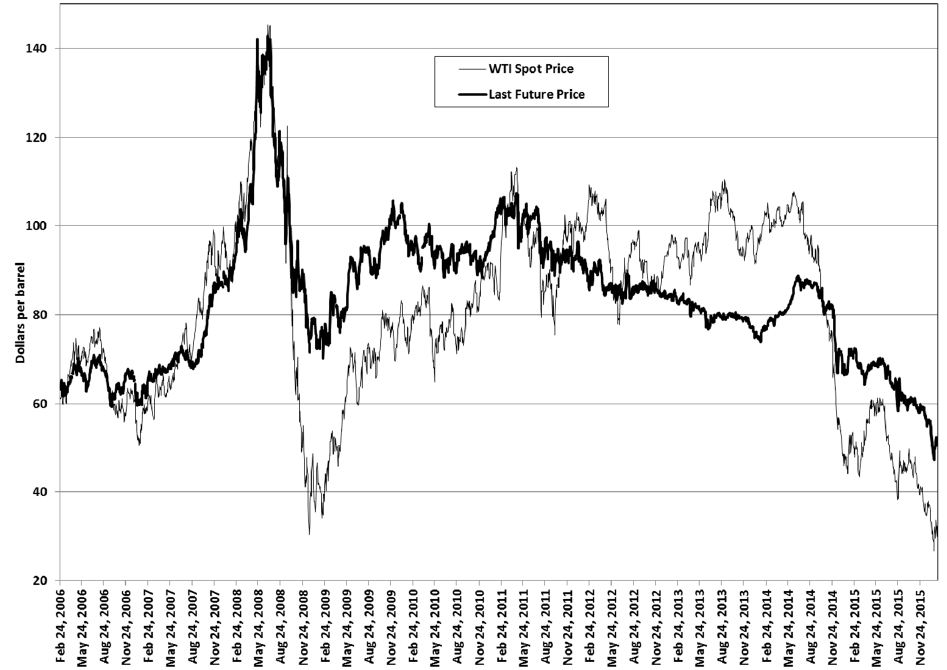
Figure 2. West Texas Intermediate (WTI) spot and longest ‐ maturity futures prices. Source: EIA and Intercontinental Exchange (ICE), respectively.